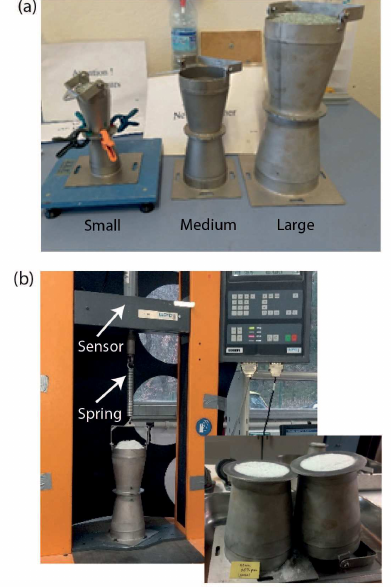
Figure 3. (a) The three sizes of the macro-scale tensile devices. (b) Picture of the traction bench. Inset: Typical failure surfaces after a